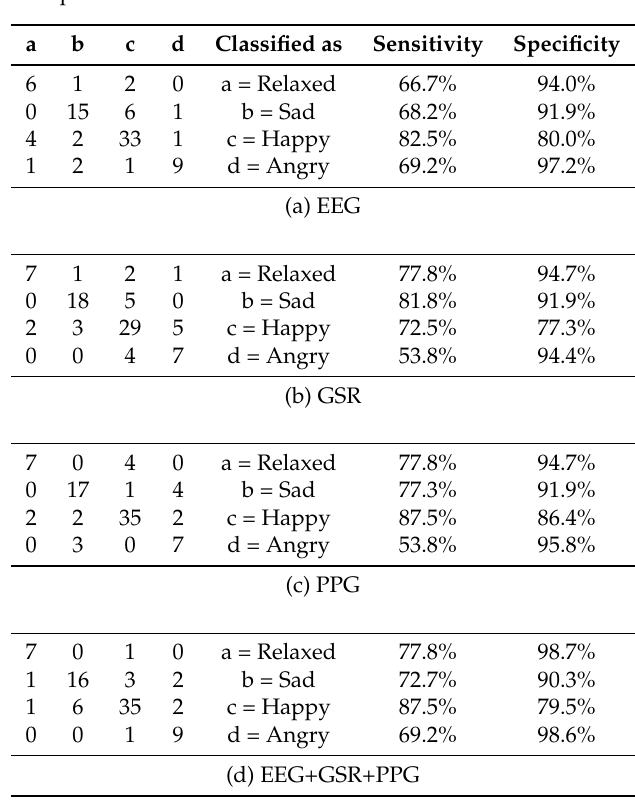
Table 5. Confusion matrices for emotion recognition using (a) EEG, (b) GSR, (c) PPG, and (d) MLF (EEG+GSR+PPG) in response to TEM